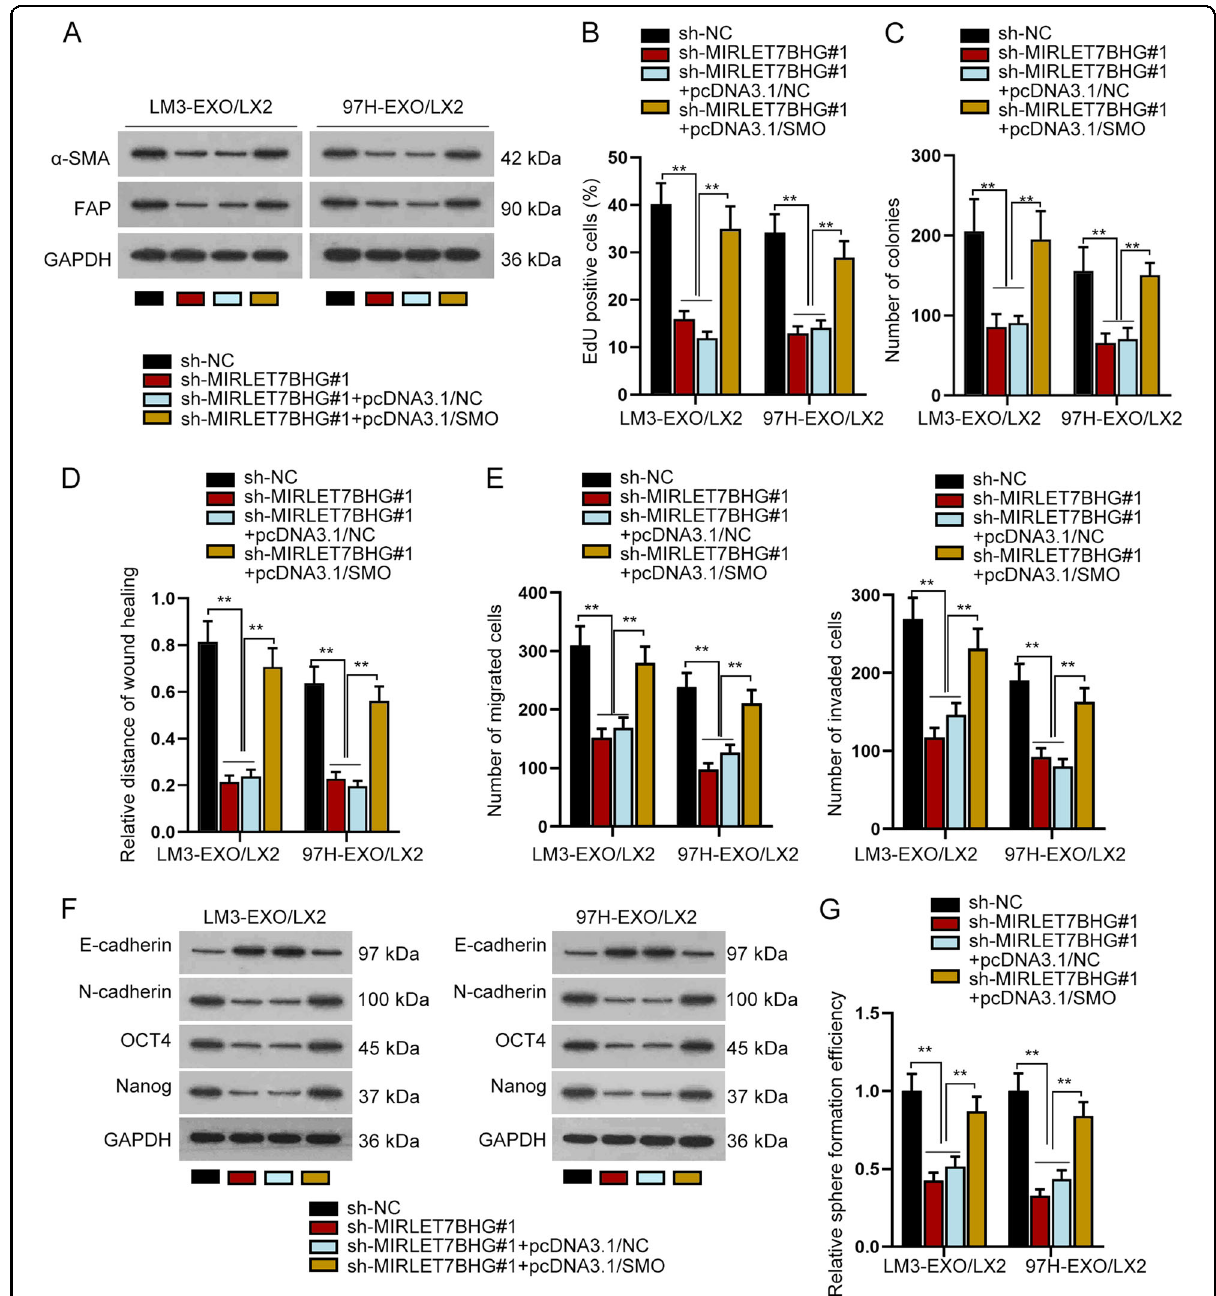
Fig. 5 MIRLET7BHG activated HSCs via upregulating SMO. There were four groups of activated HSCs under different transfections: sh-NC, sh- MIRLET7BHG#1, sh-MIRLET7BHG#1 + pcDNA3.1/NC, and sh-MIRLET7BHG#1 + pcDNA3.1/SMO. A Western blot detected the protein level of α -SMA and FAP in different groups. B – C EdU and colony formation assays examined the proliferation of activated HSCs under different contexts. D – E Wound- healing and transwell assays analyzed cell migration and invasion capacity in different groups. F – G Western blot and sphere formation assays analyzed changes in EMT process and stemness of activated HSCs in face of indicated transfections. ** P <